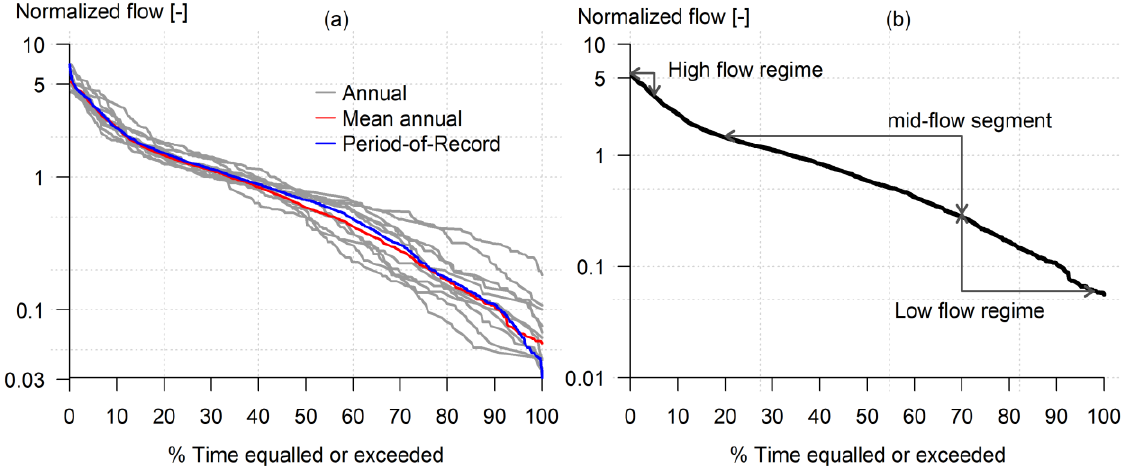
Figure 4. Flow duration curves using normalized daily streamflow (1970–1990) for the Nyangores River at ILA03 ( a ). Parts of the FDC used in this study to derive the streamflow signature information ( b ). Note that the daily streamflow is normalized with the mean annual streamflow.